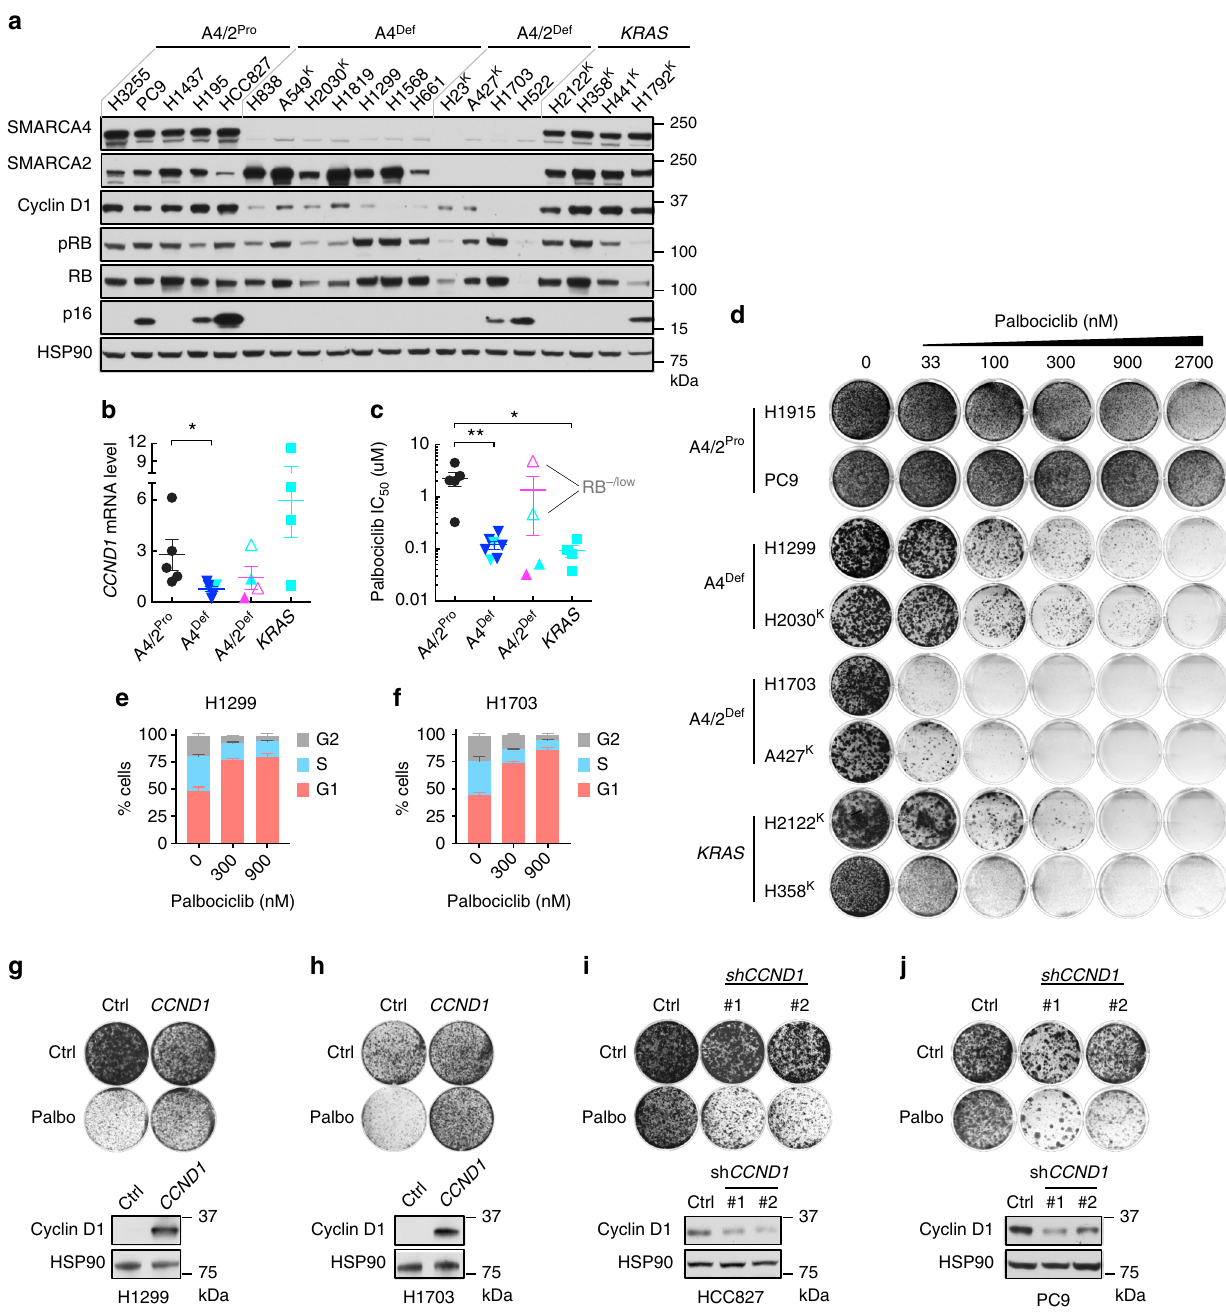
Fig. 1 Reduced cyclin D1 in SMARCA4-de fi cient non-small cell lung cancer (NSCLC) cells causessensitivities to cyclin-dependent kinase 4/6